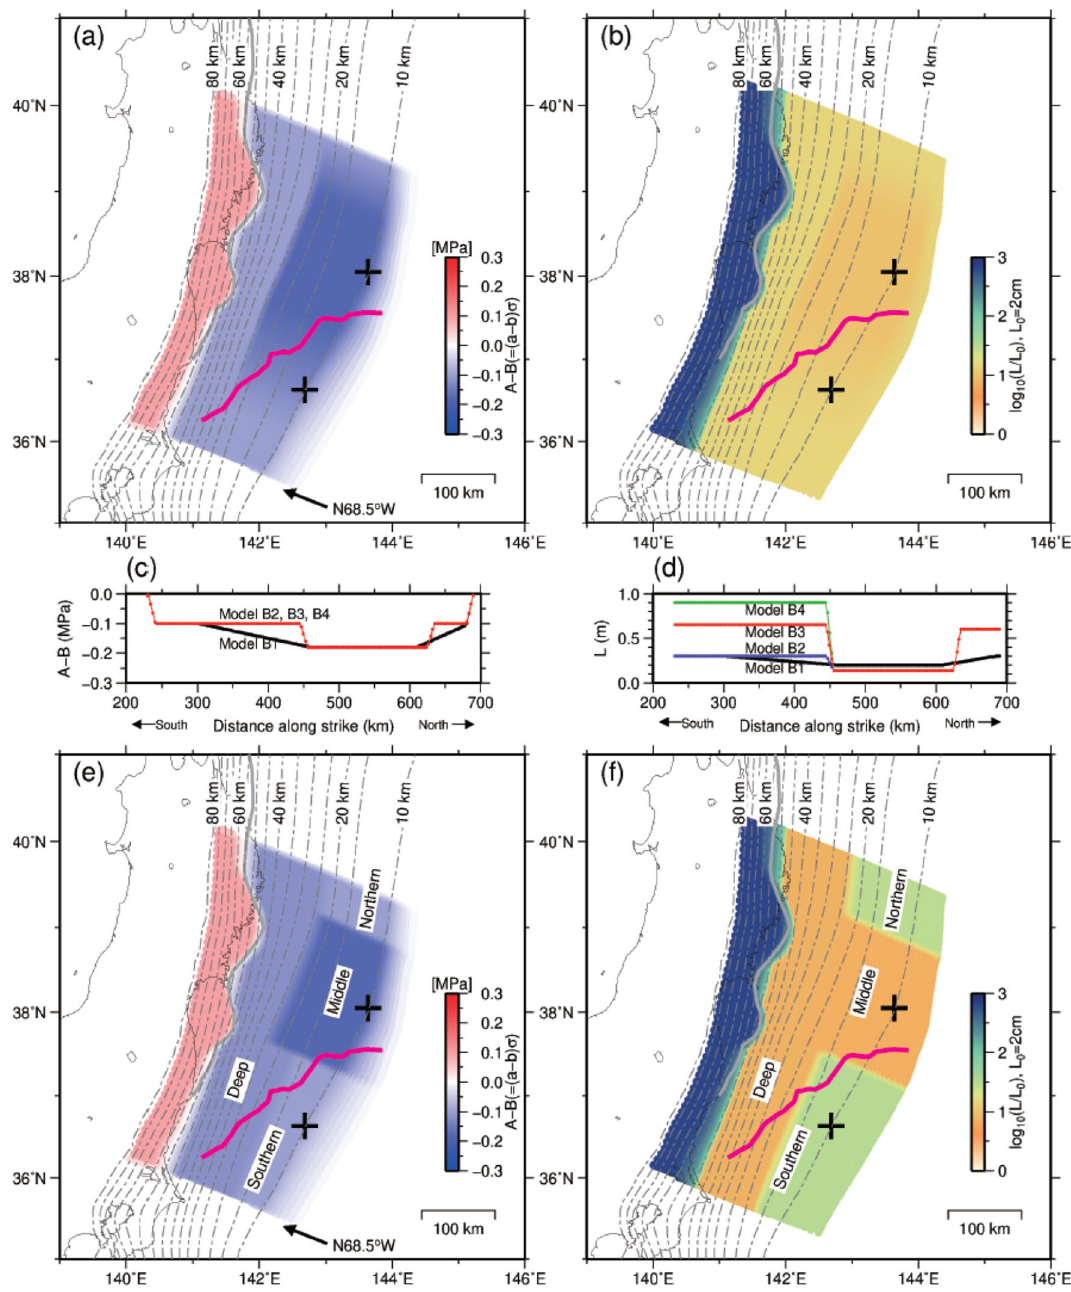
Figure 3. Distribution of frictional parameters for Model B1. ( a ) Spatial distribution on the plate interface of (A–B) (MPa). The magenta lines are the same as in Fig. 1a. Crosses indicate the points shown in Supplementary Fig. 1. Contours indicate the depth (km) to the upper surface of the descending plate 41 . The grey solid line indicates the same as the red line in Fig. 1a. ( b ) Spatial distribution of the characteristic slip distance (L). ( c )–( d ) Profiles of A–B and L along the strike at a depth of 10.15 km. Black, purple, red, and green lines represent the Model B1, B2, B3, and B4, respectively. ( e , f ) Spatial distribution on the plate interface of (A–B) (MPa) and the characteristic slip distance (L) for Model B3. Crosses indicate the points shown in Fig. 4. The descriptions of segments ‘Northern’, ‘Middle’, ‘Southern’, and ‘Deep’ are the same as those used in Table